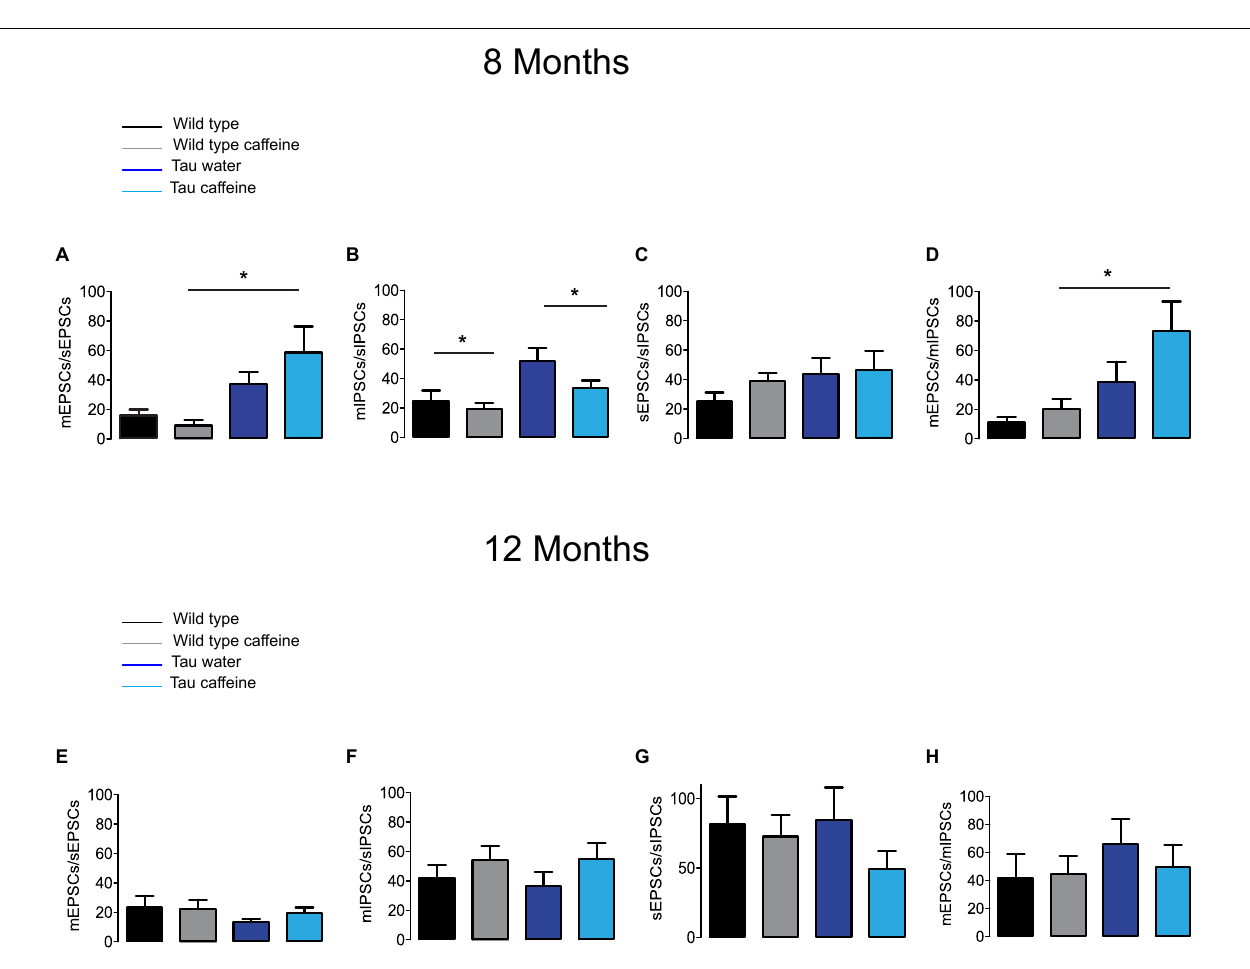
for sIPSCs we found a decrease by 20 and 26%,